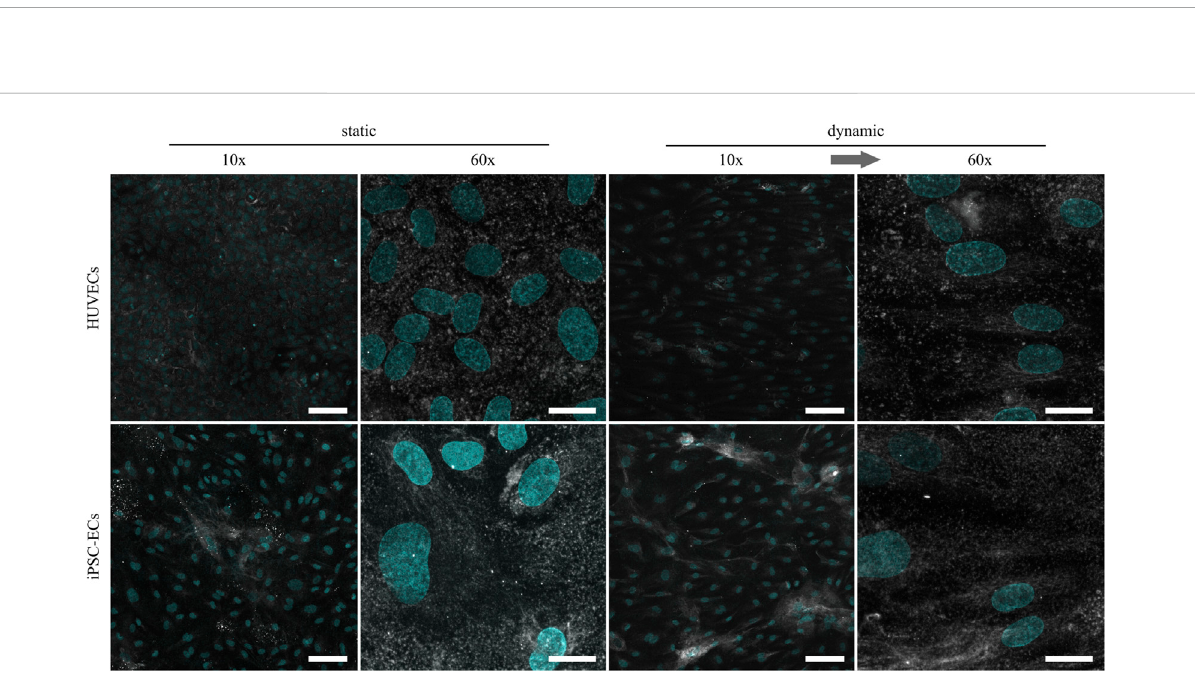
Frontiers in Cell and Developmental